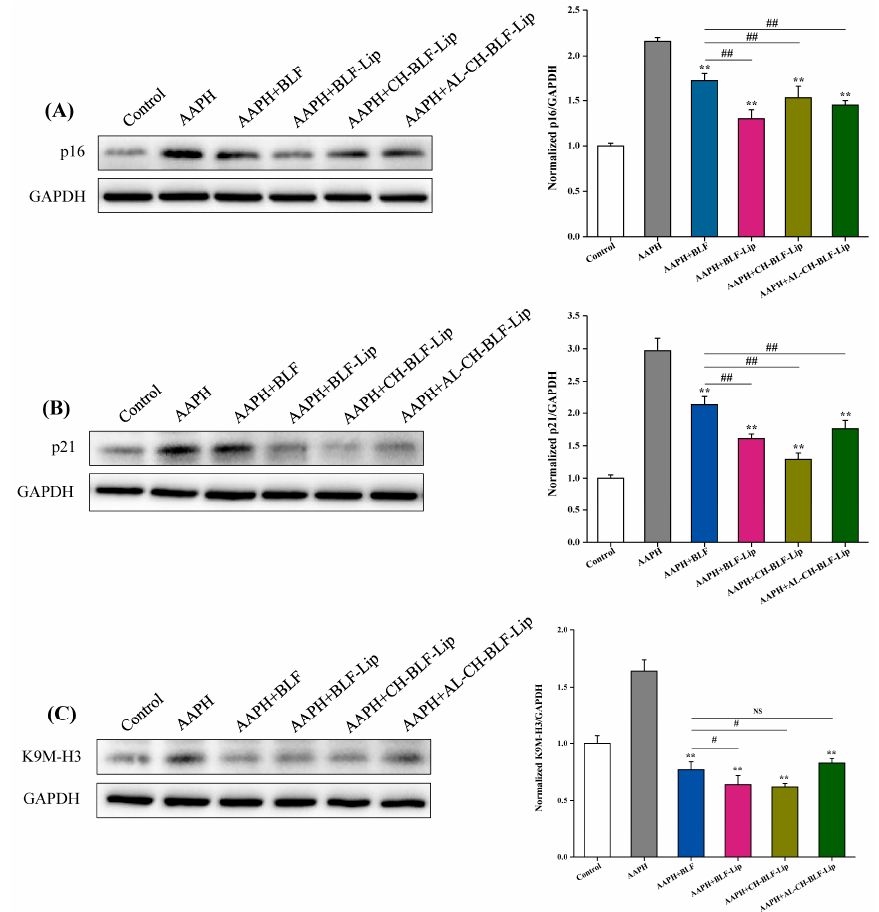
Figure 9. Protein expression of p16 ( A ), p21( B ), and K9M-H3 ( C ) determined by western blotting. Quantitation was shown on the right. Data were presented as mean ± SD of three independent replications. ** p < 0.01 vs. AAPH treated group. # p < 0.05, ## p < 0.01 vs. AAPH + BLF treated group. NS, no significant difference.